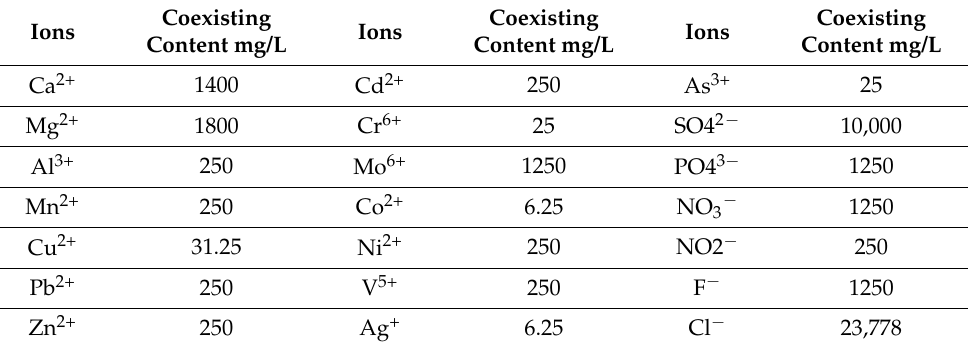
Table 4. The allowable coexisting ions in 0.5 mg/L ammonium water (measurement error less than 10% was considered as no